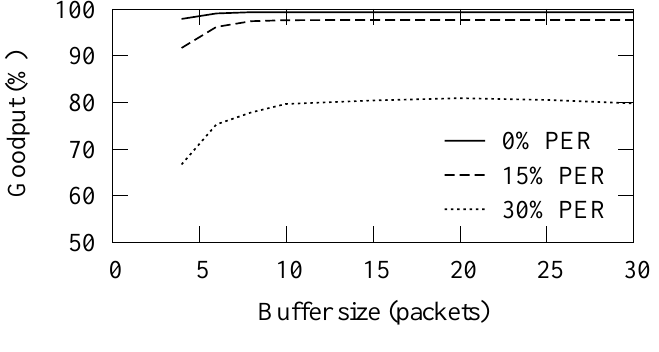
Figure 16. End-to-end reliability in ZigBee with different buffer sizes (12 sources, 15 B/s offered load).